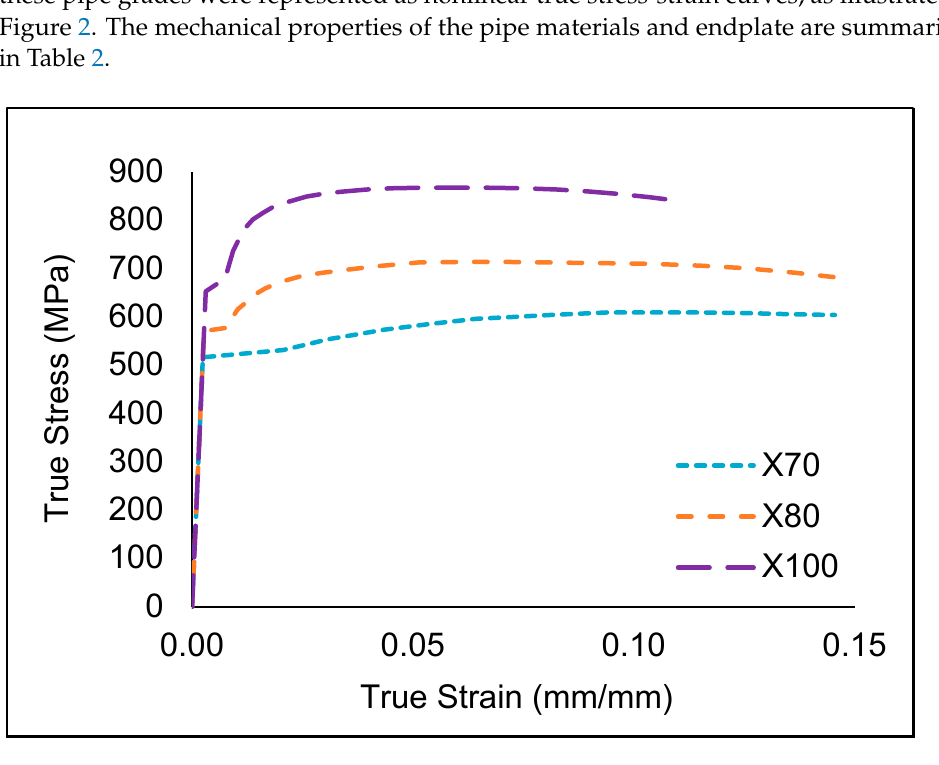
Figure 2. True stress-strain curves of API 5L X70, API 5l X80, and API 5L X100 pipe material [2,3].